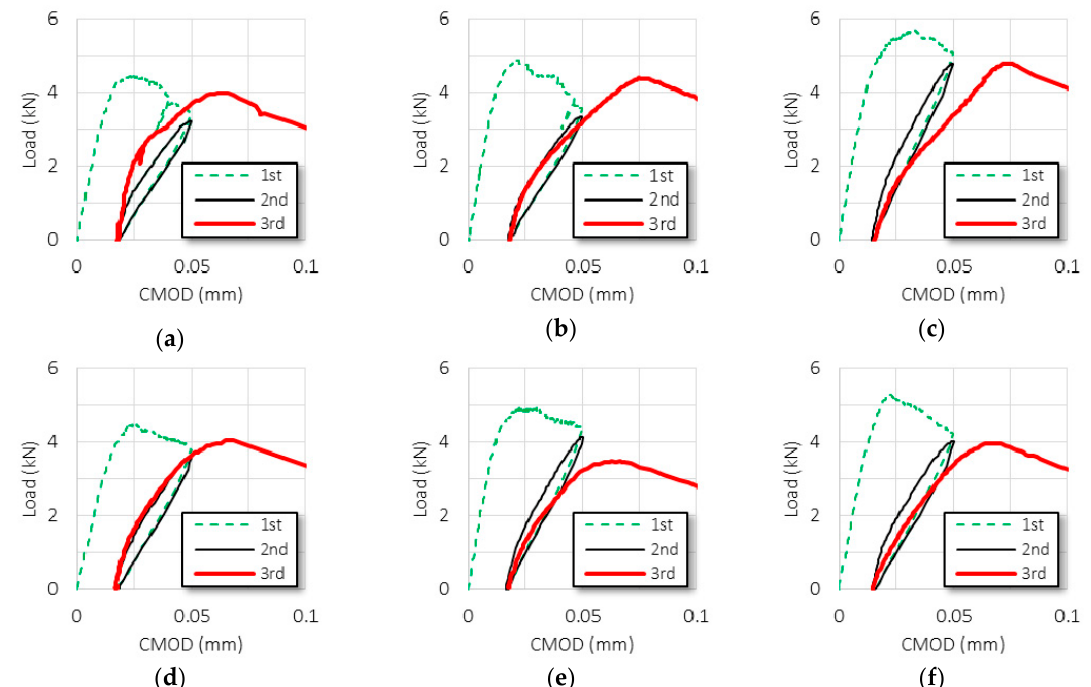
Figure 8. Typical load-CMOD curves for different crack inducement times: ( a ) 7-28W; ( b ) 28-49W; ( c ) 49-70W; ( d ) 7-28A; ( e ) 28-49A; ( f ) 49-70A.